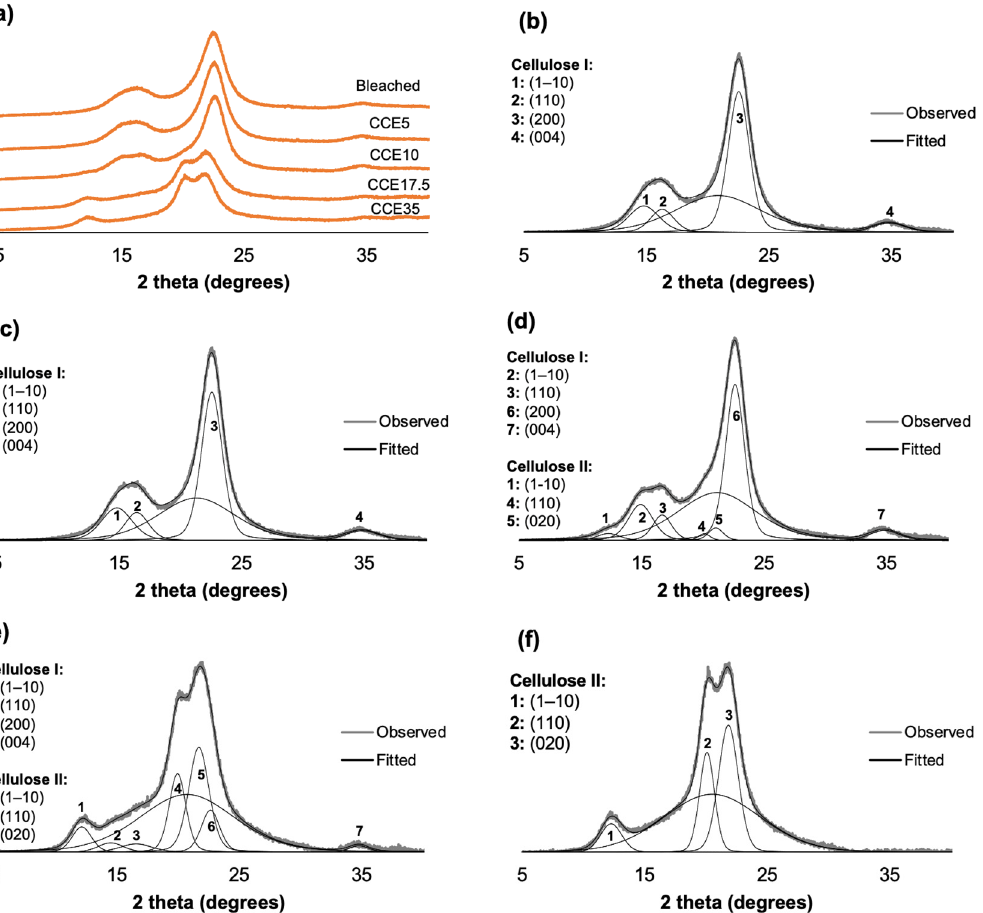
Figure 3. Eucalyptus XRD diffractograms. ( a ) XRD diffractograms of eucalyptus pulp after alkaline treatment, ( b ) curve-fitting of bleached kraft pulp, ( c ) curve-fitting of CCE5, ( d ) curve-fitting of CCE10, ( e ) curve-fitting of CCE17.5, and ( f ) curve-fitting of CCE35 eucalyptus sample.